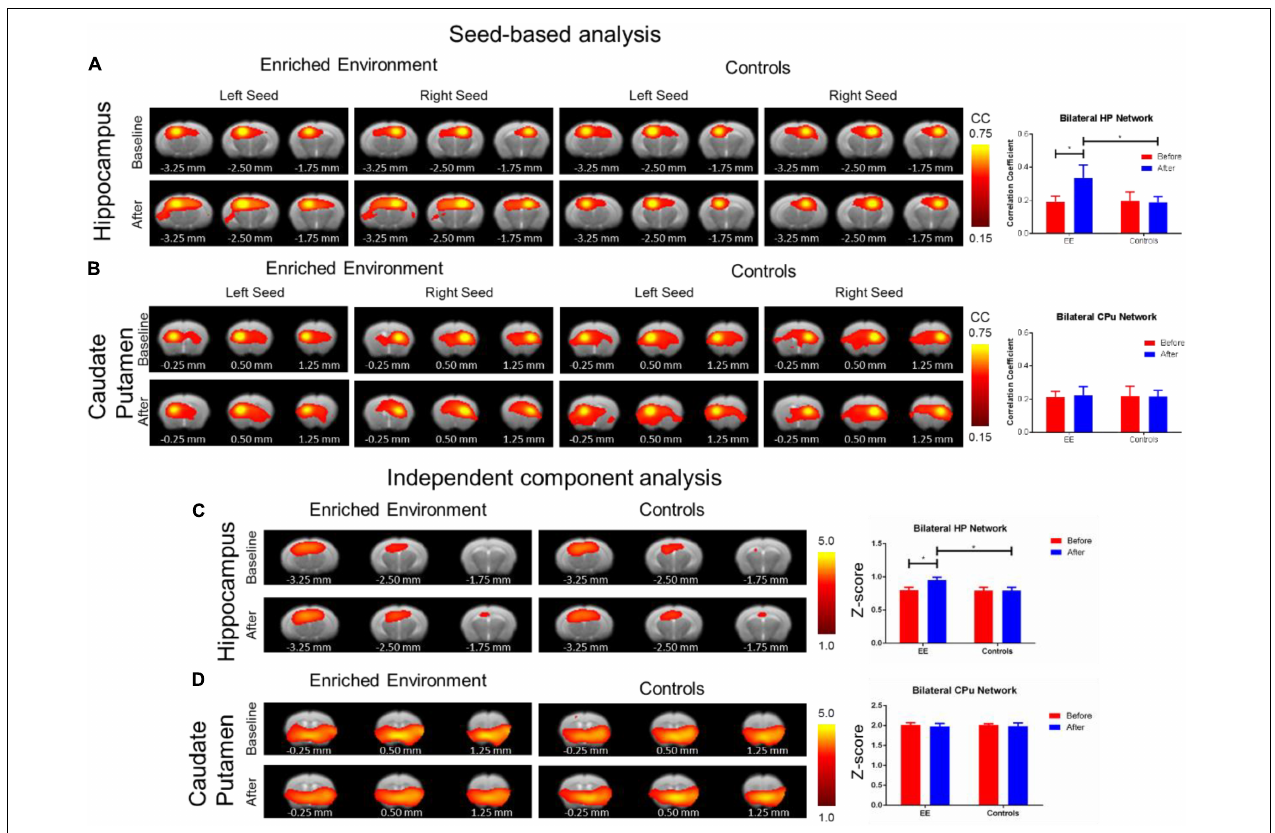
FIGURE 4 | Resting-state functional alterations from environmental enrichment. The SBA analysis: The rsfMRI connectivity change before and after EE compared with the SE controls. (A) Functional connectivity maps (left) of the hippocampal (HP) network resulting from SBA for right and left hemisphere seed. Bar plots of average functional connectivity in HP (right) before (red) and after (blue) environmental enrichment. There was a significant increase in hippocampal functional connectivity after environmental enrichment compared with the naïve period as well as compared with the SE controls. (B) Functional connectivity maps (left) of the CPu network resulted from SBA for the right and left hemisphere seed. Bar plots of the average functional connectivity in CPu (right) before (red) and after (blue) the EE. In contrast to the hippocampal network, the Cpu network remained relatively unchanged after the EE. Color bar represents correlation coefficient from 0.75 yellow to 0.45 red. The asterisk * indicates significant p < 0.05 based on the F -test. The ICA analysis: The rsfMRI connectivity change before and after the EE compared with the SE controls. (C) Functional connectivity maps (left) of the hippocampal (HP) network resulted from ICA. Bar plots of average z -scores in HP (right) before (red) and after (blue) environmental enrichment. There was a significant increase in the hippocampal functional connectivity after environmental enrichment compared with the naïve period as well as compared with the SE controls. (D) Functional connectivity maps (left) of the CPu network resulted from ICA. Bar plots of average z -scores in Cpu (right) before (red) and after (blue) environmental enrichment. In contrast to the hippocampal network, the CPu network remained relatively unchanged after environmental enrichment. The color bar represents z -scores from 5.0 yellow to 1.0 red. The asterisk * indicates significant p < 0.05 based on the F -test. Bregma AP coordinates are listed below each brain